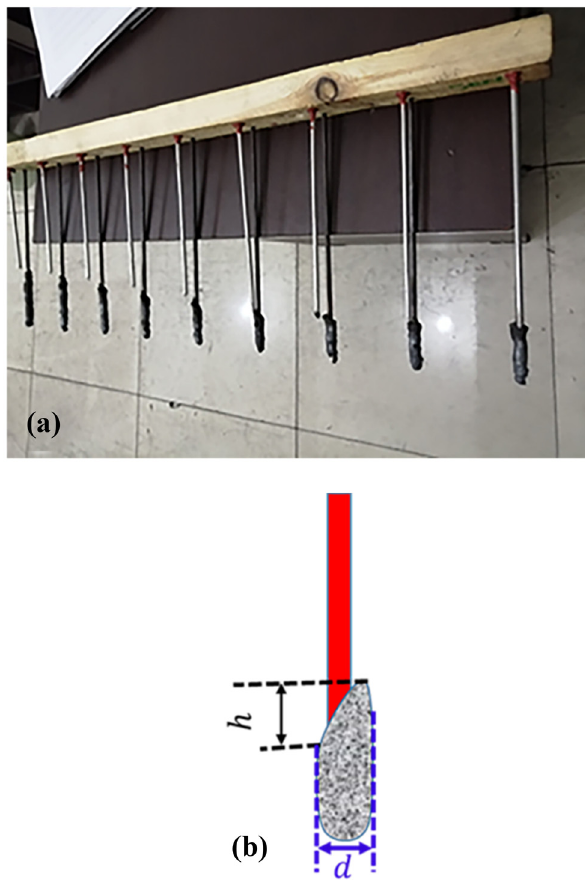
Figure 18: Dipping tests: ( a ) morphology of nails after dipping tests and ( d ) solidi fi ed steel lumps characteristic